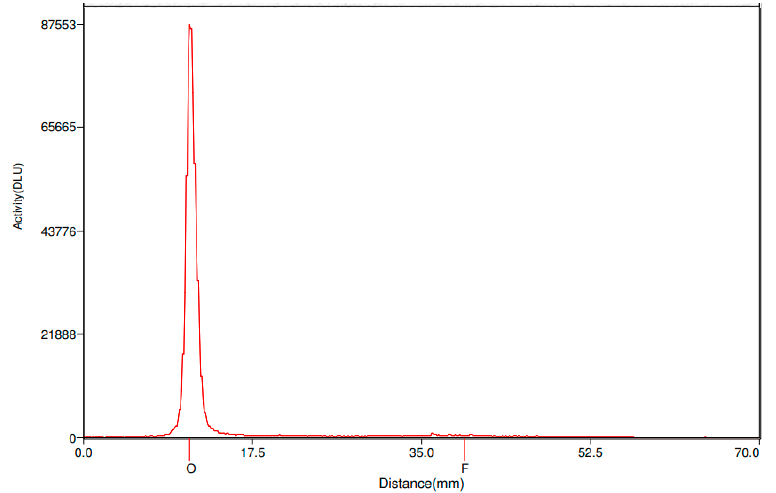
Figure 3. Radiochemical yield and purity assessed by iTLC. Here is a typical chromatogram of 177 Lu-DTPA-h5A10. Distribution of radioactivity along the iTLC was visualized and quantified using Cyclone Storage Phosphor System. The radiolabelled product remains at the origin while any free radionuclide migrates with the